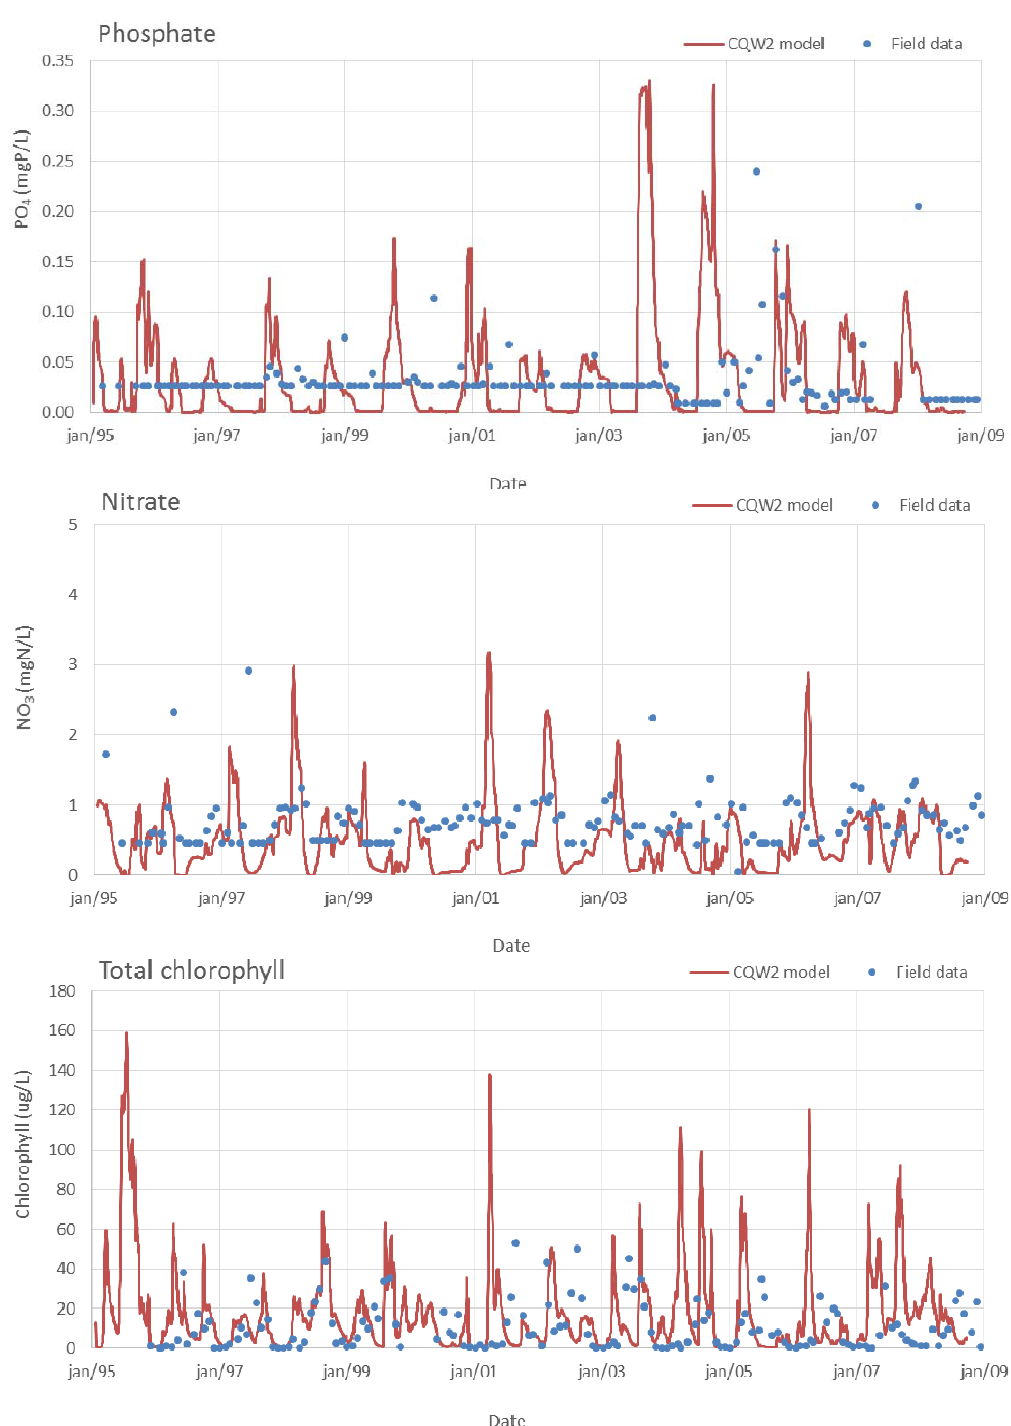
Figure 6. Surface nutrients and chlorophyll concentrations at Torrão reservoir (model estimates and field